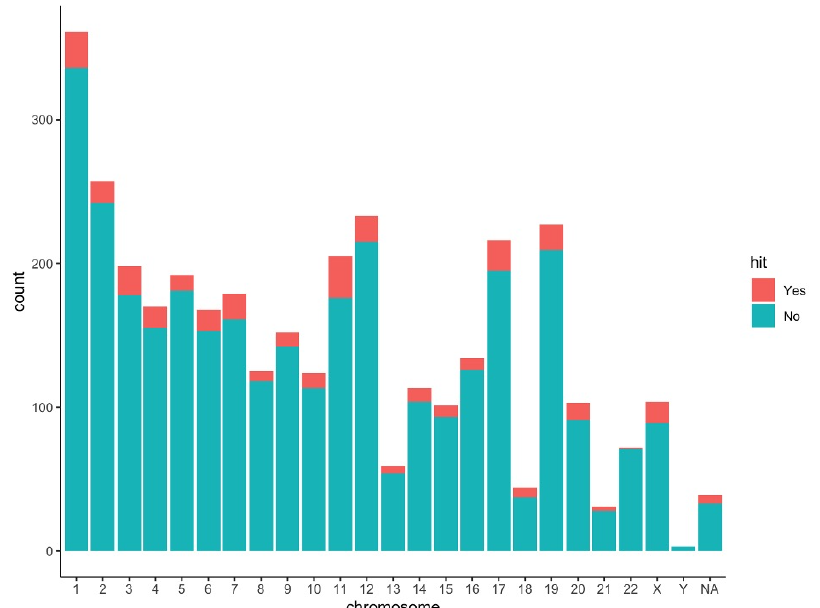
Figure 5. Distribution of commonly linked genes (green and red) and identified common drivers (red) in each human chromosome.